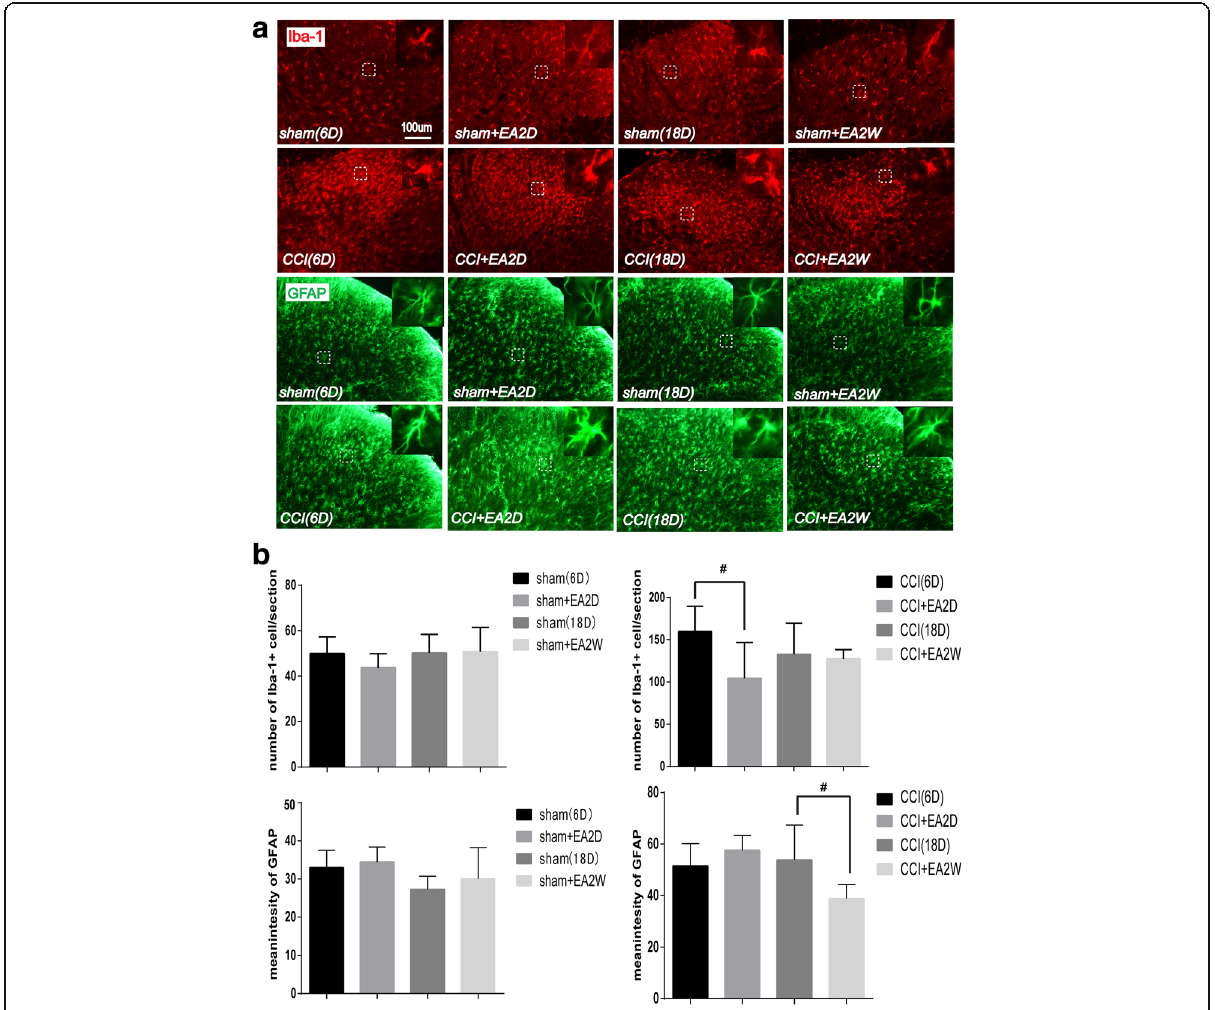
Fig. 4 Immunofluorescence staining showing activities of microgliacytes and astrocytes in Ipsi and Cont DHs of lumbar spinal cord on day 6 and 18 after CCI in rats. a Representative tissue sections of immunofluorescence staining showing Iba-1-labeled microgliacytes (red) and GFAP-labeled astrocytes (green) in the Ipsi DHs of the lumbar spinal cord. In the superior-right corner of each section, the magnified microgliacyte and astrocyte from each dashed square box are shown. b Bar graphs showing the numbers of microgliacytes and mean fluorescence intensity values of GFAP (for astrocytes) in the Ipsi DHs on day 6 and 18 in the sham and EA groups(mean±SD, n=6/group). Results showed that in the early period of CCI-induced neuropathic pain, 2 days ’ EA suppressed the activation of microgliacytes (not astrocytes), and in the later period, 2 weeks ’ EA suppressed the activation of astrocytes. # P<0.05, vs the CCI